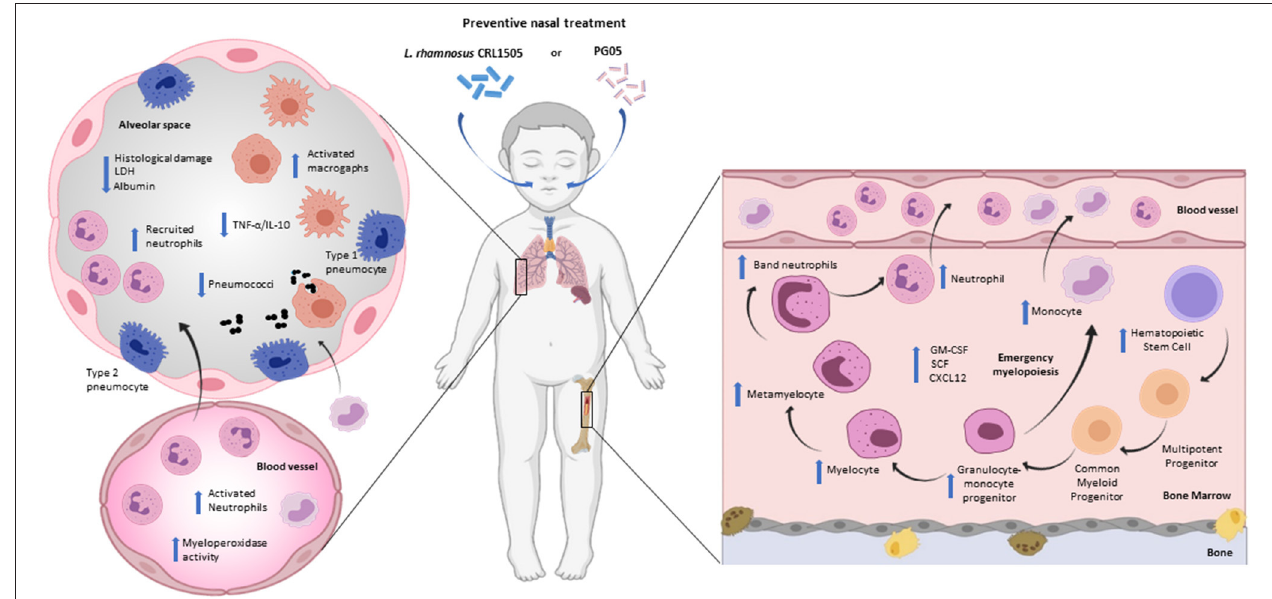
FIGURE 2 | Modulation of respiratory innate immunity by immunobiotic or postbiotic nasal treatments in malnourished host. Proposed mechanism for the distal immunomodulation induced by the immunobiotic strain Lactobacillus rhamnosus CRL1505 or its peptidoglycan and the enhancement of the resistance against Streptococcus pneumoniae infection through the improvement of the lung innate immune response and myelopoiesis (Figure created with